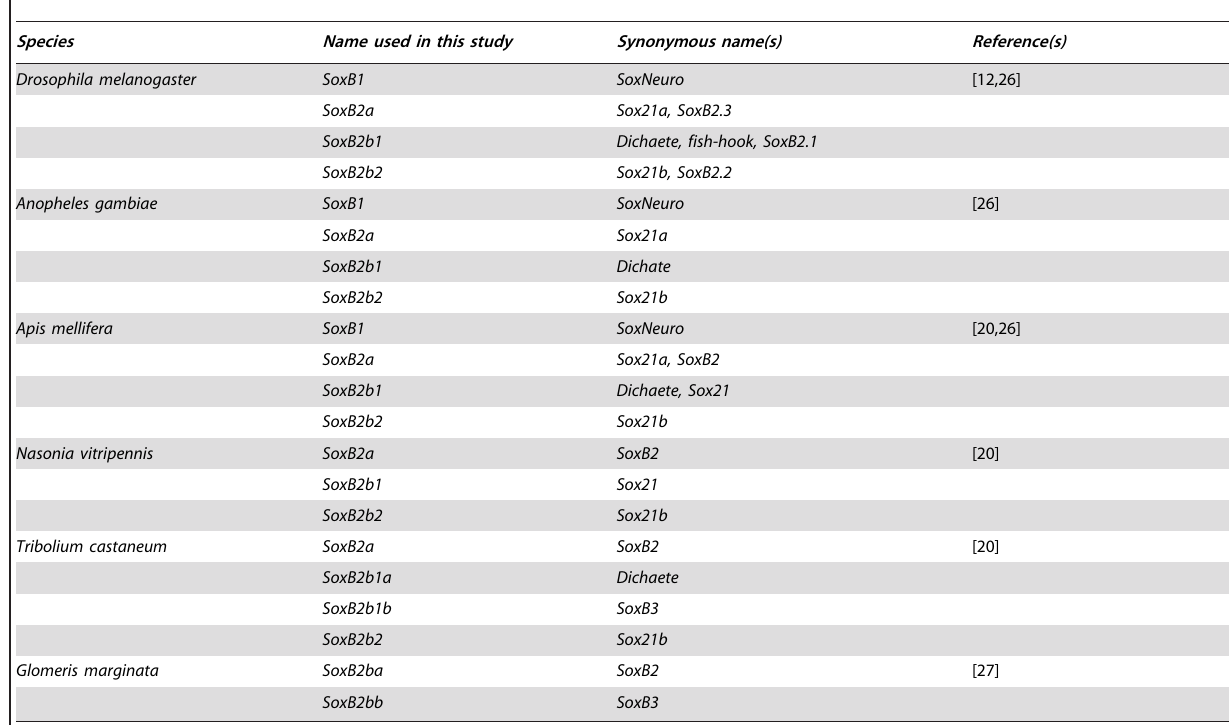
Table 2. Synonymous Names for Arthropod SoxB